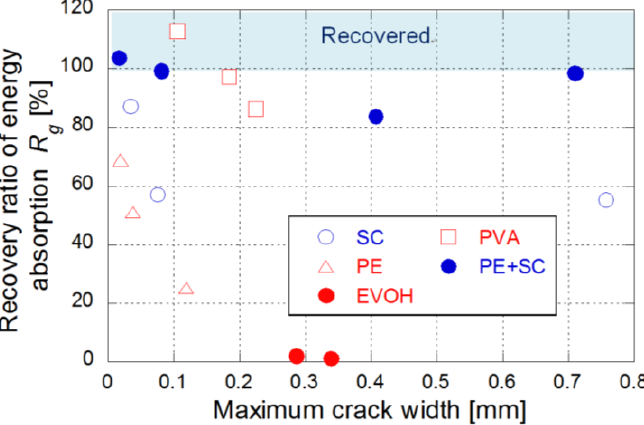
Figure 11. Relationship between recovery ratio of energy absorption ( ) and maximum crack